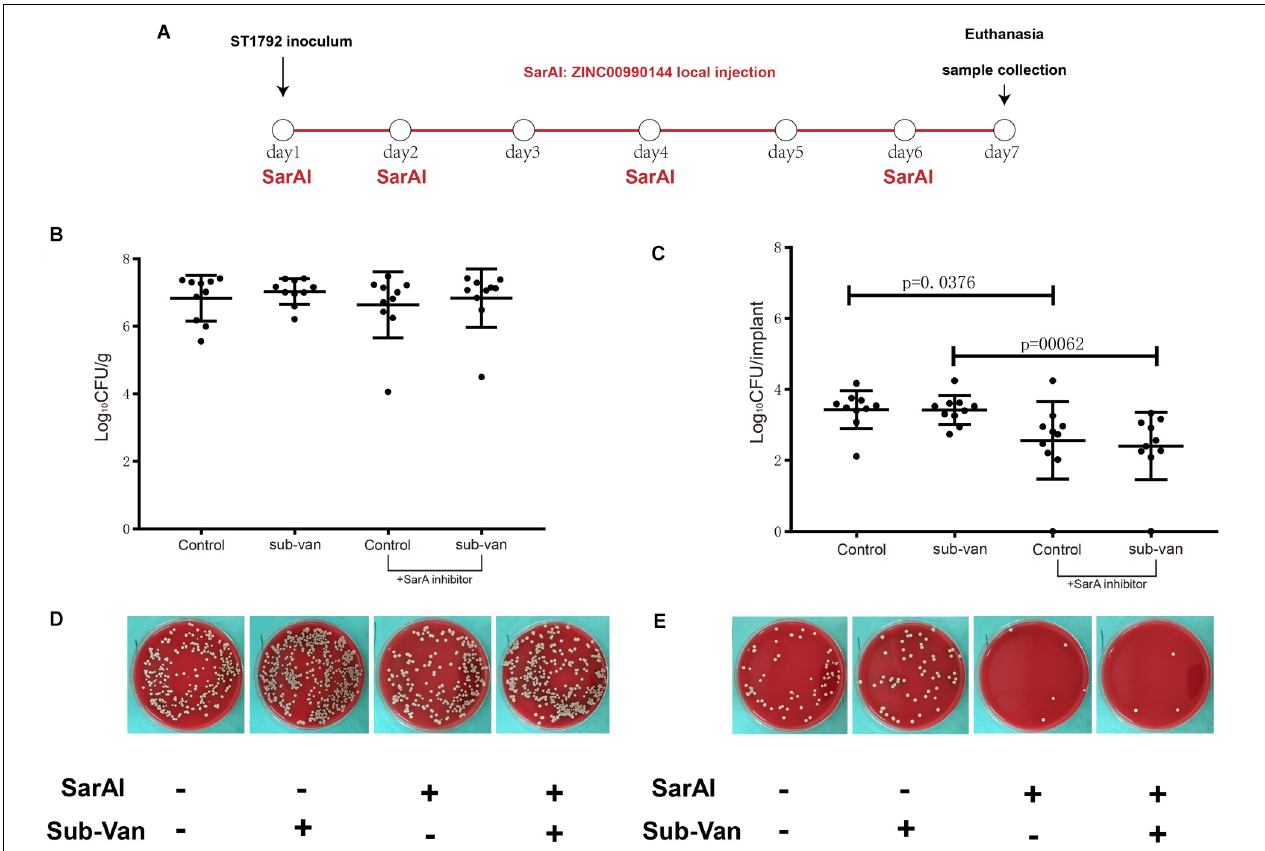
FIGURE 7 | Role of ZINC00990144 in the mice model of implant infection. (A) Schematic diagram for process of in vivo experiment. SarA inhibitor was used in implant infection mice model at day1, 2, 4, 6. All of the mice were sacrificed at day 7. (B–E) Quantification of bacterial load for the implant and surrounding infected tissue. (B,D) Bacteria count on surrounding tissues. (C,E) Bacteria count on implant and representative photos.